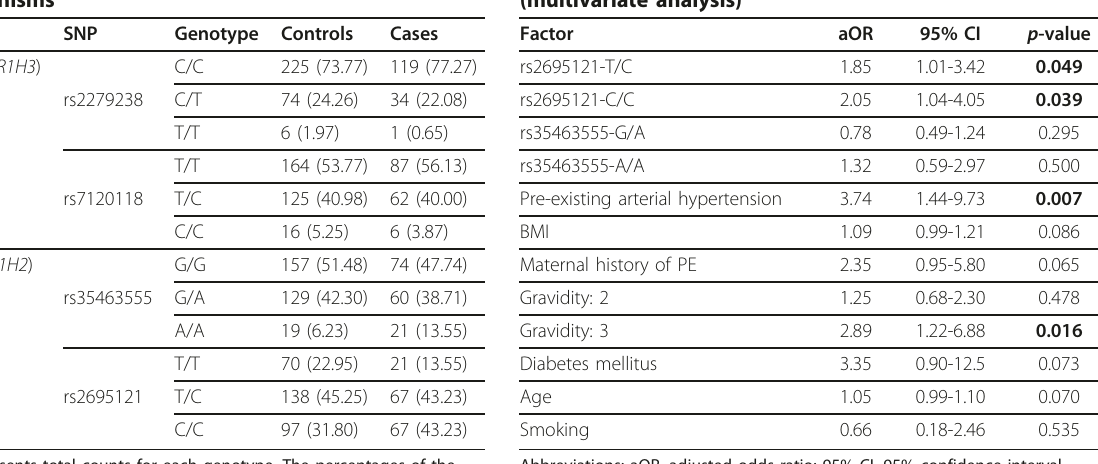
Table 6 Logistic regression model of risk factors for PE